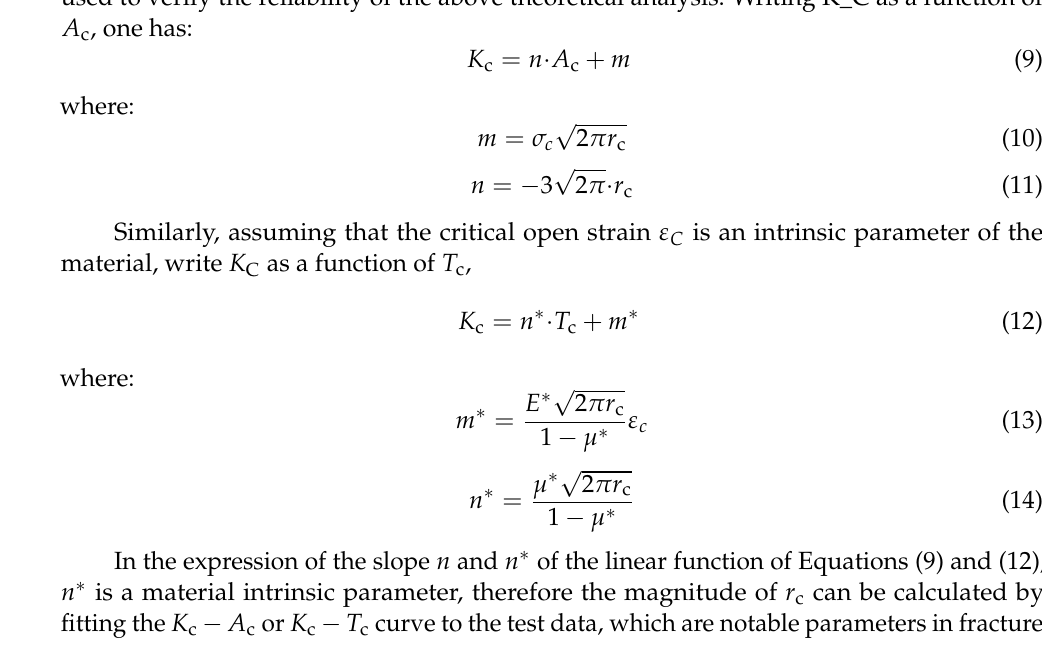
( b ) Figure 2. Load–displacement curves in the vertical direction: ( a ) (cid:1832) (cid:3051) = 1.21 kN ( b ) (cid:1832) (cid:3051) = 0.98 kN. 00.20.40.60.811.21.41.61.82 0.00 0.05 0.10 0.15 0.20 0.25 0.30 0.35 0.40 0.45 0.50 0.55 0.60 0.65 l o a d ( k N )